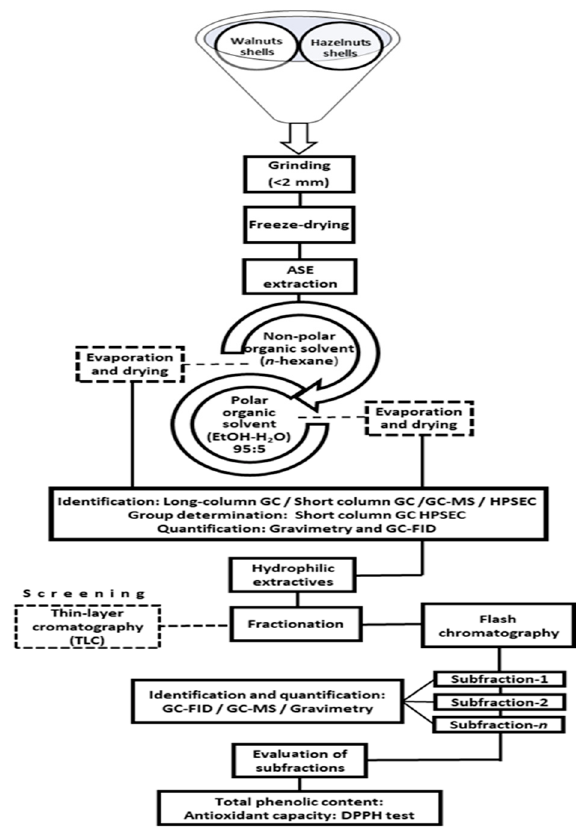
Figure 1. Protocol for extraction, fractionation, and evaluation of nutshells.